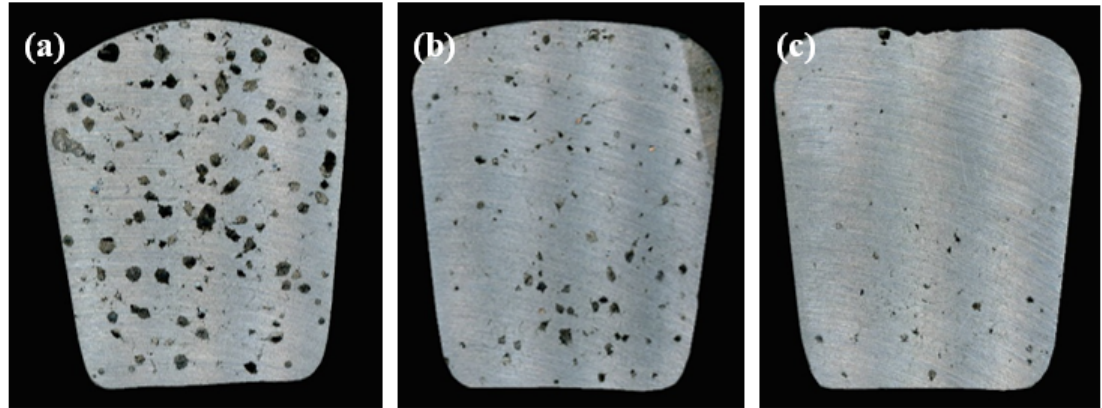
Figure 2. Porosity content for samples taken from Reduced Pressure Test (RPT) under partial vacuum; ( a ) without degassing; ( b ) with degassing tablet; and ( c ) degassed with high-shear melt conditioning.